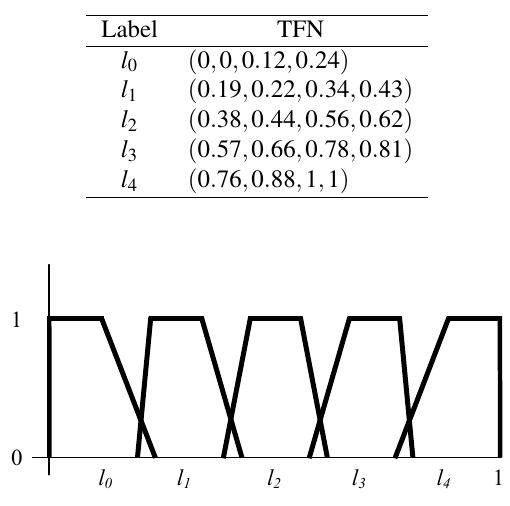
Fig. 2. Graphical representation of the previous